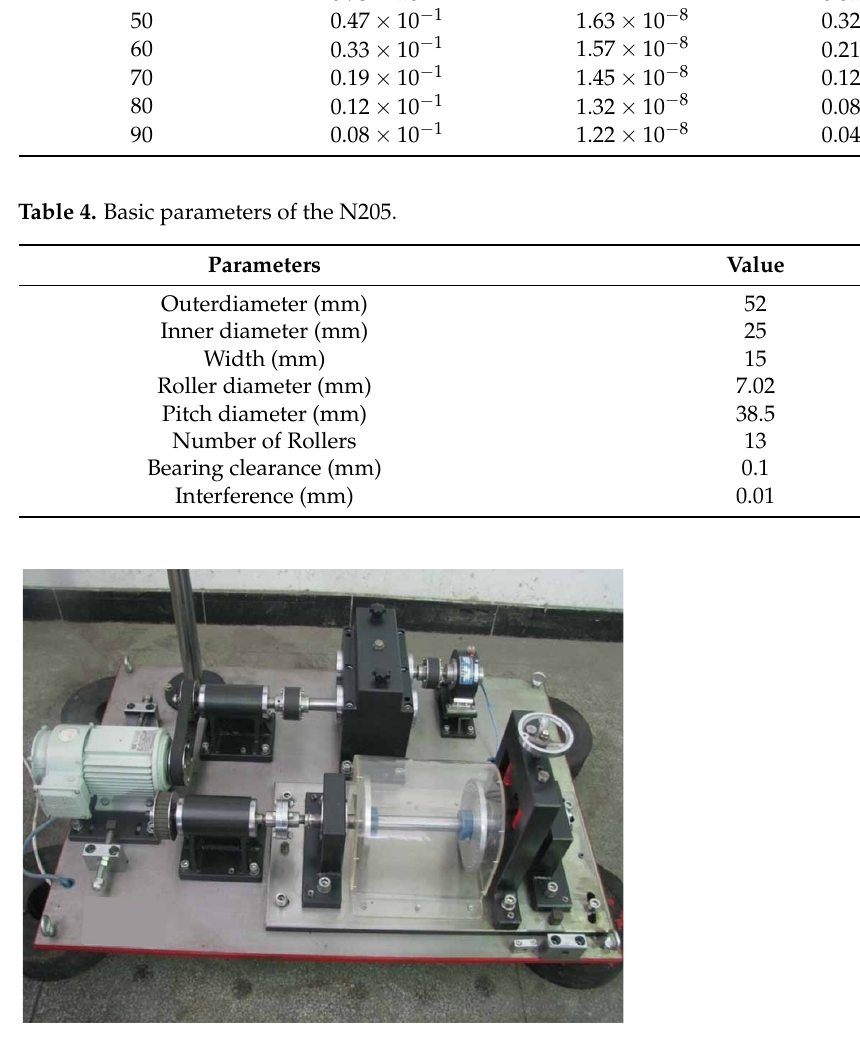
Figure 6. The bearing temperature acquisition and experiment platform.